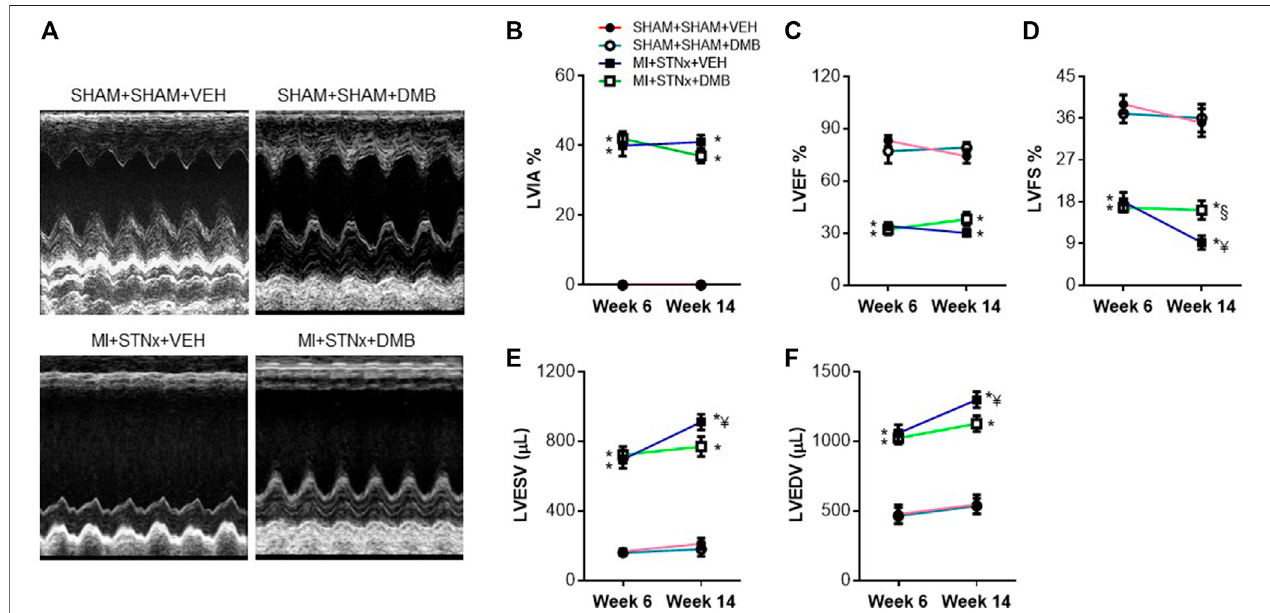
FIGURE 2 | Representative M-mode echocardiograms obtained with two-dimensional guidance from a long-axis ventricular view in each group (A) and effects of CRS2 and DMB treatment on echocardiographic variables including percent left ventricular ischemic area (LVIA%) (B) , LV ejection fraction (LVEF) (C) , LV fractional shortening(LVFS) (D) ,LVvolumesatendcardiacsystole(LVESV) (E) andLVvolumesatendcardiacdiastole(LVEDV) (F) .Dataareexpressedasmean ± SE( n (cid:1) 8 – 10for each group). * p < 0.05 vs SHAM + SHAM + VEH at each time point; ¥ p < 0.05 vs week 6; § p < 0.05, MI + STNx + DMB vs MI + STNx + VEH.